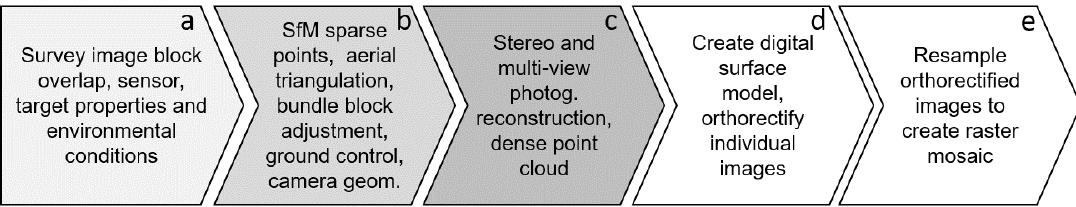
Figure 1. The major steps required to create an orthrectified image mosaic include ( a ) operator decisions and sensor; ( b ) structure from motion (SfM) and iterative algorithms to reconstruct camera pose; ( c ) photogrammetric matching algorithms; ( d ) filtering and surface model reconstruction; ( e ) raster prioritisation, resampling and/or